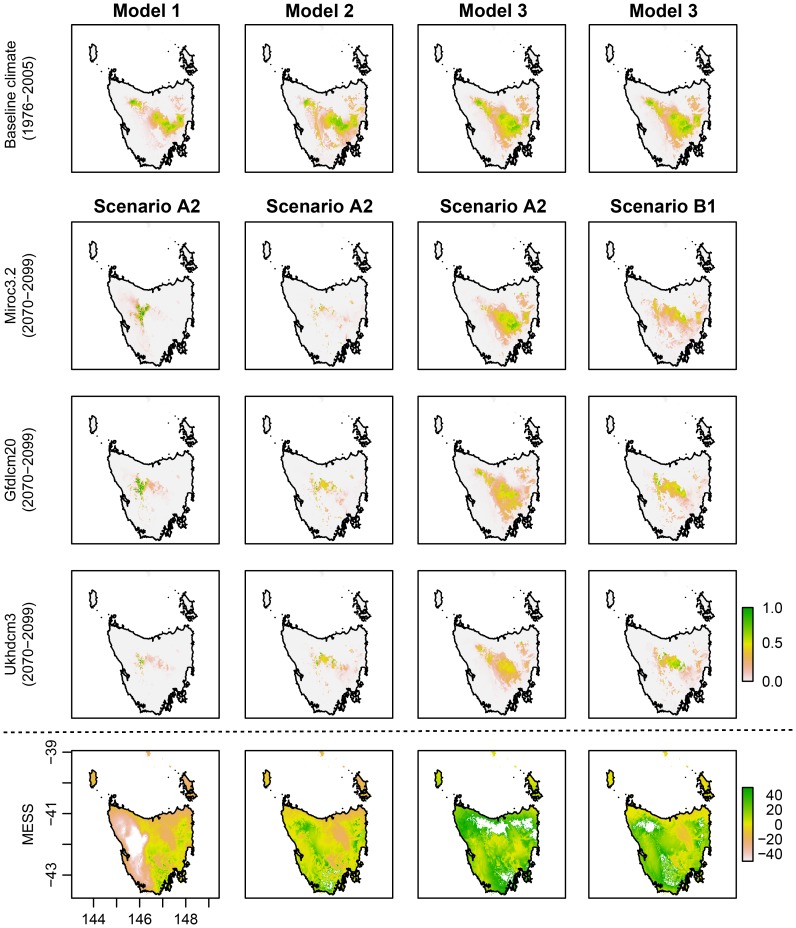
Distribution maps for the Ptunarra Brown Butterfly using baseline climate data (Row 1) and climate projections from three global circulation models (GCMs) for the period 2070–2099 (Rows 2–4) using two CO2 emissions scenarios: A2 for Models 1 to 3 (Columns 1–3) and B1 (Column 4, only for Model 3).